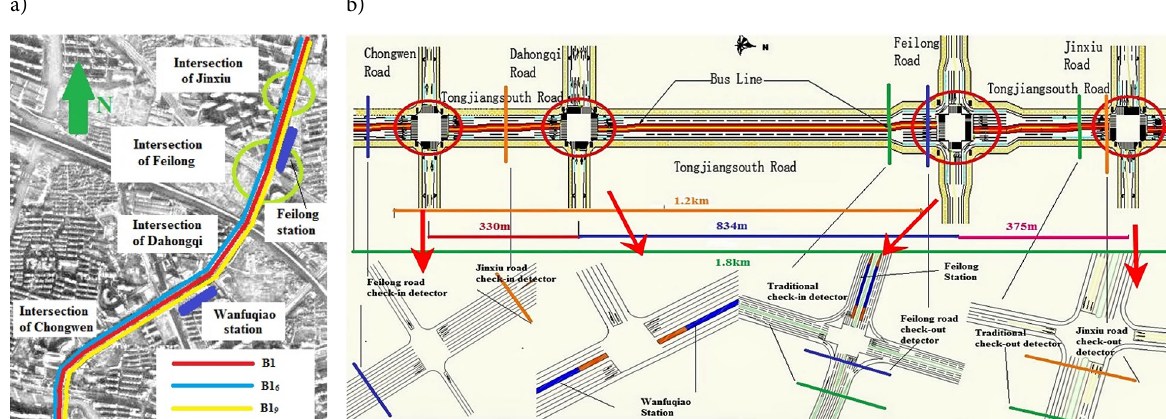
Fig. 3. Tongjiang south road in Changzhou (a) and sketch map of intersections in the study